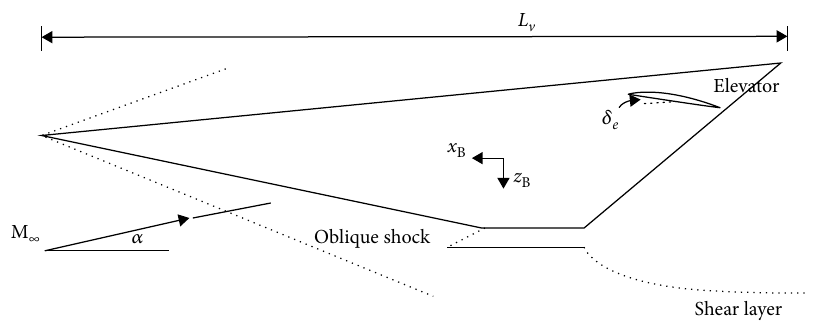
Figure 1: Geometry of the hypersonic